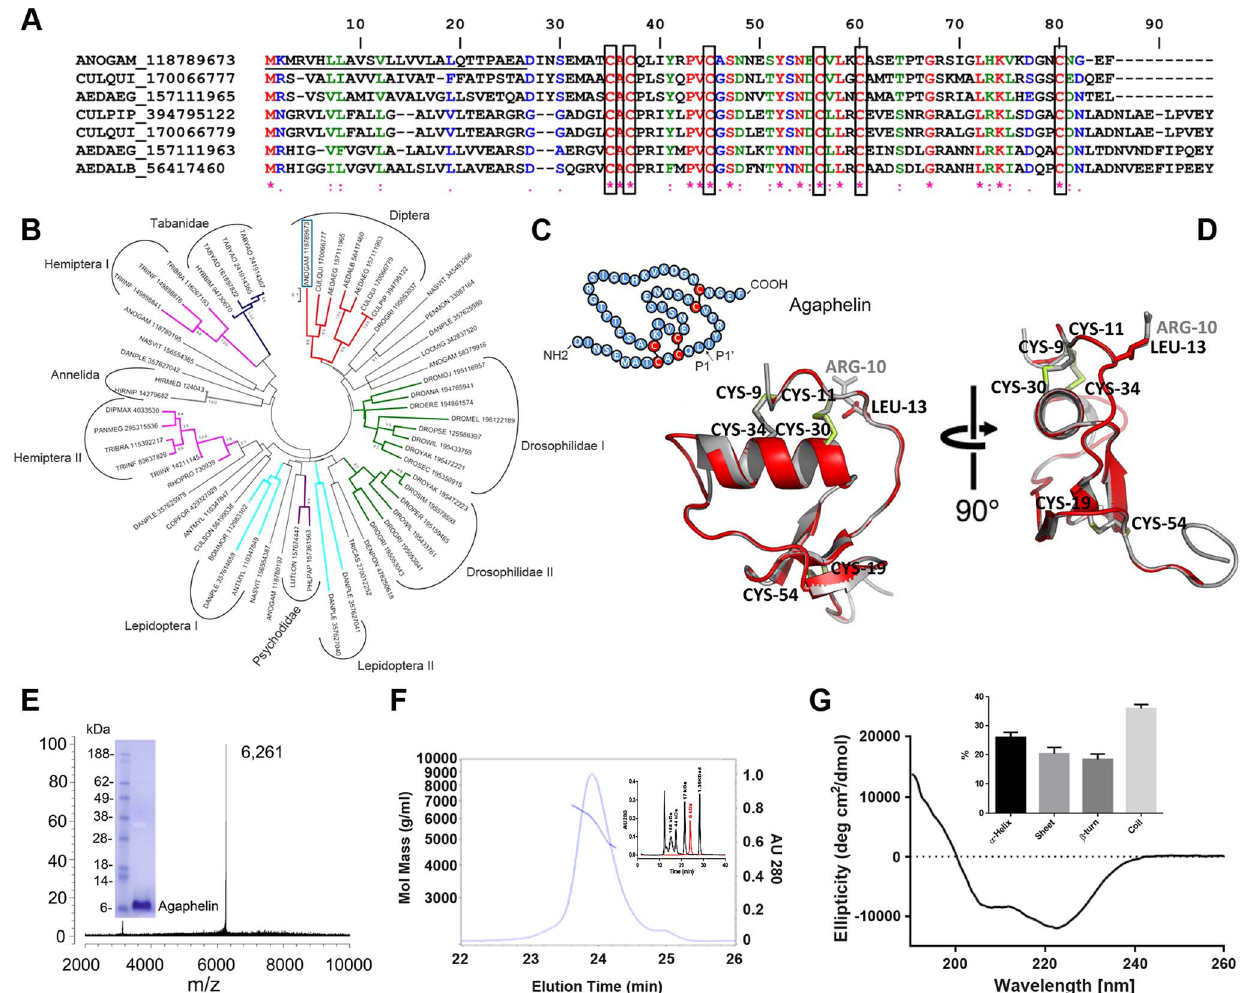
Figure 1. Characterization of Agaphelin. A) Clustal alignment of Agaphelin (gi| 118789673) with other proteins of the Kazal superfamily from Diptera. The boxes indicate the six conserved cysteines. Symbols below the alignment indicate: (*) identical sites; (:) conserved sites; (.) less-conserved sites. The underlined represent the signal peptide. B) Phylogram of Agaphelin (blue box) and other organisms obtained by the neighbor-joining algorithm using pairwise deletion and Poisson model. Sequences from the nonreduntant protein database of the National Center for Biotechnology Information (NCBI) are represented by the first three letters of their genus name, followed by the first three letters of the species name, followed by gi| accession number. Numbers in the phylogram nodes indicate percent bootstrap support for the phylogeny after 10,000 iterations. The bar indicates 10% amino acid divergence in the sequences. C) Secondary structure of Agaphelin [31,34]. D) Structural model of Agaphelin (red) superimposed to Infestin 4 (gray). The six cysteines and the residue at position P1 from Agaphelin are labeled in black while the P1 residue of Infestin 4 is labeled in gray. Disulfide bonds are marked in yellow. E) Mass spectrometry analysis for Agaphelin. Inset : SDS/PAGE of Agaphelin, under reducing conditions. F) Analysis by SEC-MALS-HPLC provided the molar mass distribution of the main peak compared with absorbance at 280 nm. The continuous and interrupted lines represent absorbance 280 nm and MALS results, respectively. Inset : molecular weight markers (black lines) were loaded in the same column, and elution time was compared with Agaphelin (red line). G) Circular dichroism spectrum of Agaphelin showing a negative peak maxima at 222.6 nm and 208.0 nm and a positive peak maximum at 190 nm, indicating significant a -helix content. The ellipticity (degrees cm 2 /dmol) was plotted as a function of wavelength (nm) composition of Agaphelin. Data show the percentage of each type of secondary structure as determined by DichroWeb server (inset).